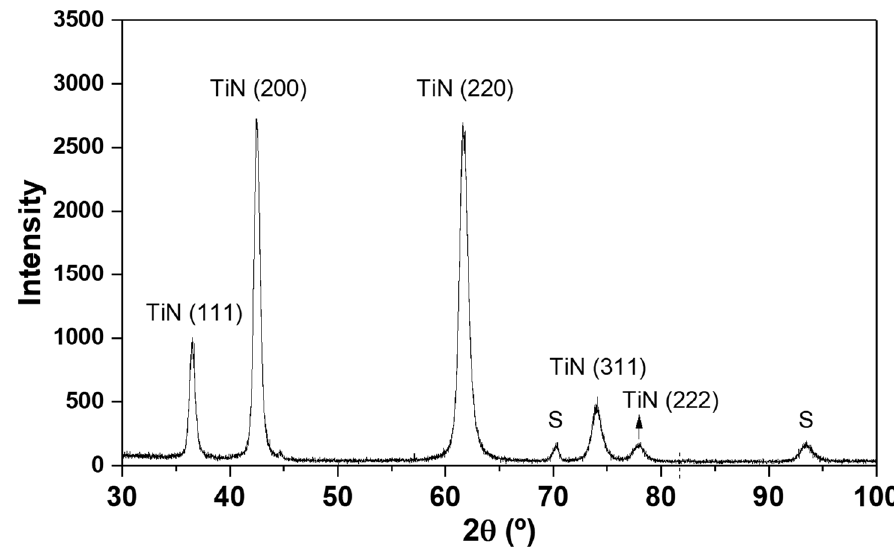
Figure 4. XRD diffraction patterns of the TiN thin film deposited by PVD.